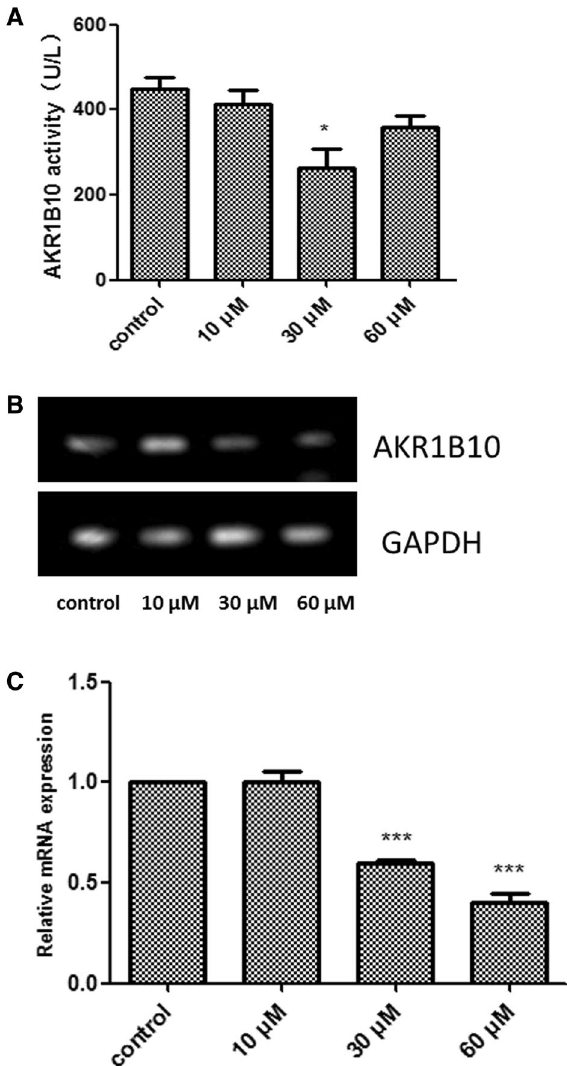
Figure 3. ( A ) Effects of oleanolic acid on aldosterone reductase family 1 member B10 (AKR1B10) enzyme activity. * P < 0.05, compared with the control group. ( B ) Aldosterone reductase family 1 member B10 mRNA expression in Hep-2 cells following treatment with oleanolic acid. ( C ) Quantification of aldosterone reductase family 1 member B10 (AKR1B10) mRNA expression in Hep-2 cells following treatment with oleanolic acid. *** P < 0.001 compared with the control